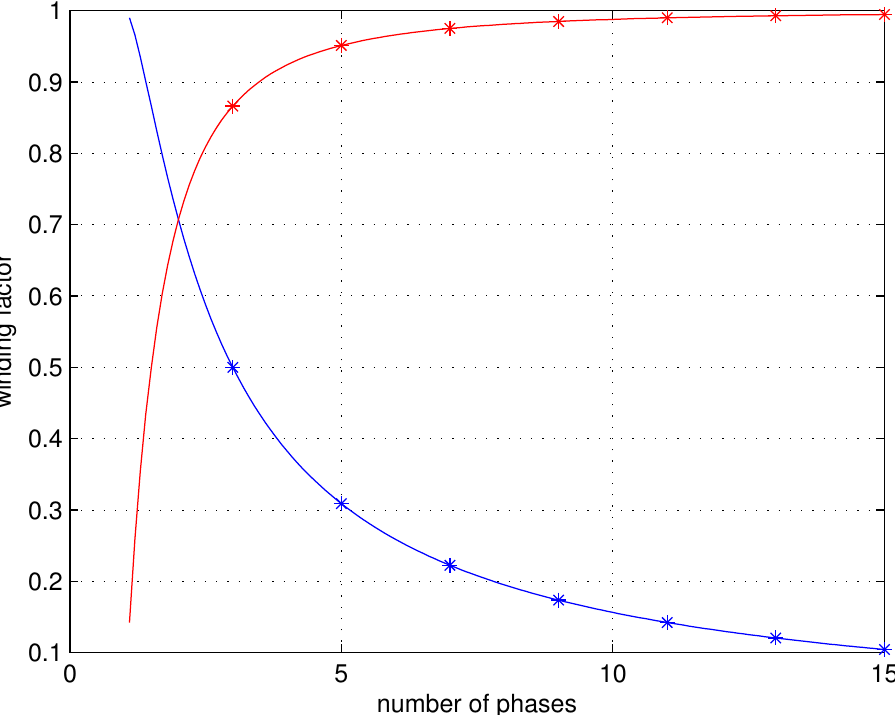
Figure 4. Winding factor of FSPMSMs having an odd number of phases made up of the parallel connection of their coils. Legend: (red) case of Figure 1, (blue) case of Figure